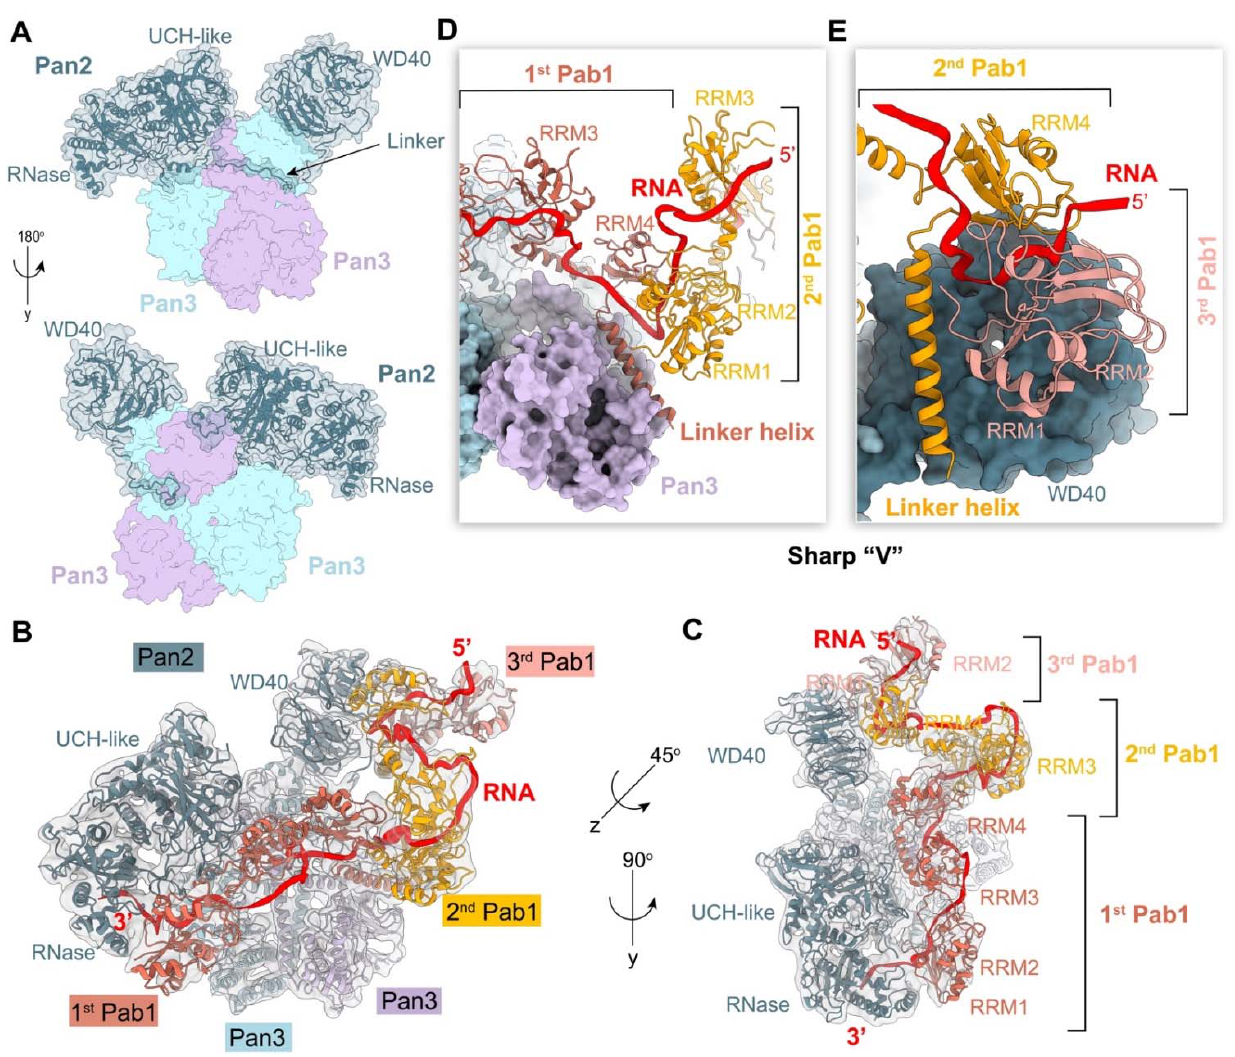
Figure 6. The architecture of the poly(A) RNP-Pan2-Pan3 complex. ( A ) Structure of the apo Pan2-Pan3 complex [60]. The two Pan3 molecules are in light blue and purple, respectively. The molecular surface of Pan2 is shown as a transparent surface. The black arrow indicates the important linker between the UCH domain and the WD40 domain of Pan2. ( B , C ) Cryo-EM density for the entire poly(A) RNP-Pan2-Pan3 complex (gray, semitransparent), in side view ( B ) and top view ( C ), fitted with the model of Pab1, Pan2, and Pan3. The poly(A) RNA is shown by a red ribbon. PDB 6R5K. ( D , E ) The interaction between the Pan2-Pan3 complex and the Pab1-Pab1 oligomerization interface. The pseudokinase domain of Pan3 (purple) and the WD40 domain of Pan2 are shown on the molecular surface. The linker helix in RRM4 is labeled. The RRM4 and the RRM1-RRM2 domains of the following Pab1 shape the substate RNA into a sharp “V”